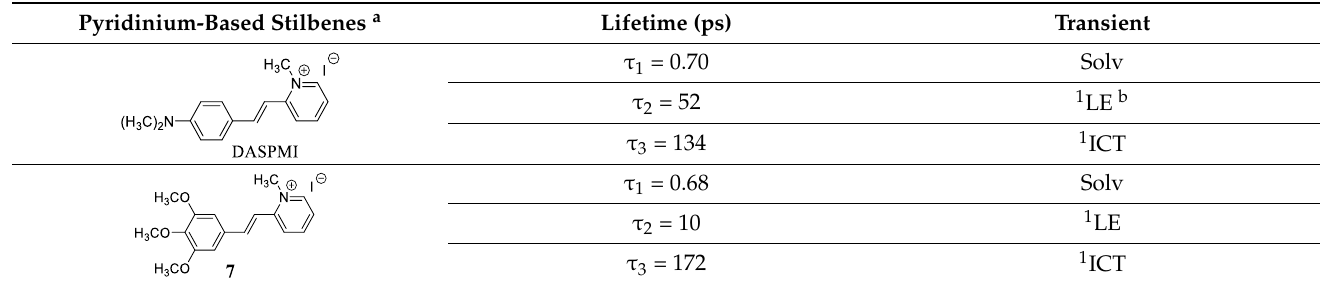
Table 3. Fluorescence lifetime data of ESIPT compounds in CH 2 Cl 2 .